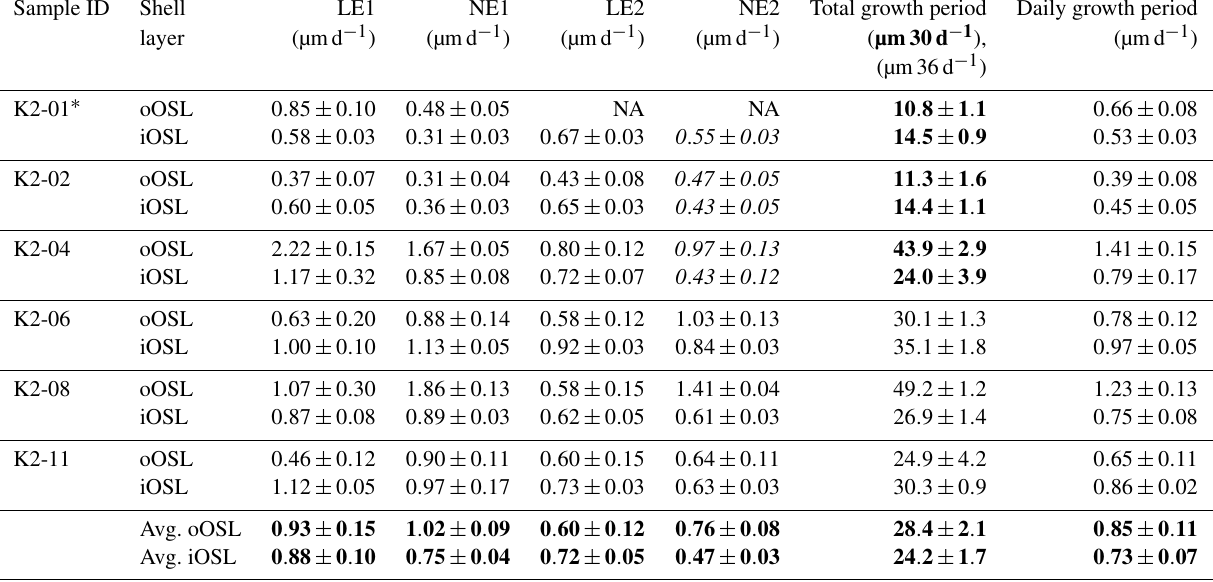
Table 2. Average daily local growth rates from pulsed Sr-labelling experiments. Rates in bold in NE2 were formed within 6d (K2-01 to K2-04), all other rates in this column are within 12d (K2-06 to K2-11). Average daily local growth rates for the entire experimental period are 0.85 (oOSL) and 0.73µm (iOSL) For full detailed lists of all measurements see Tables S3 and